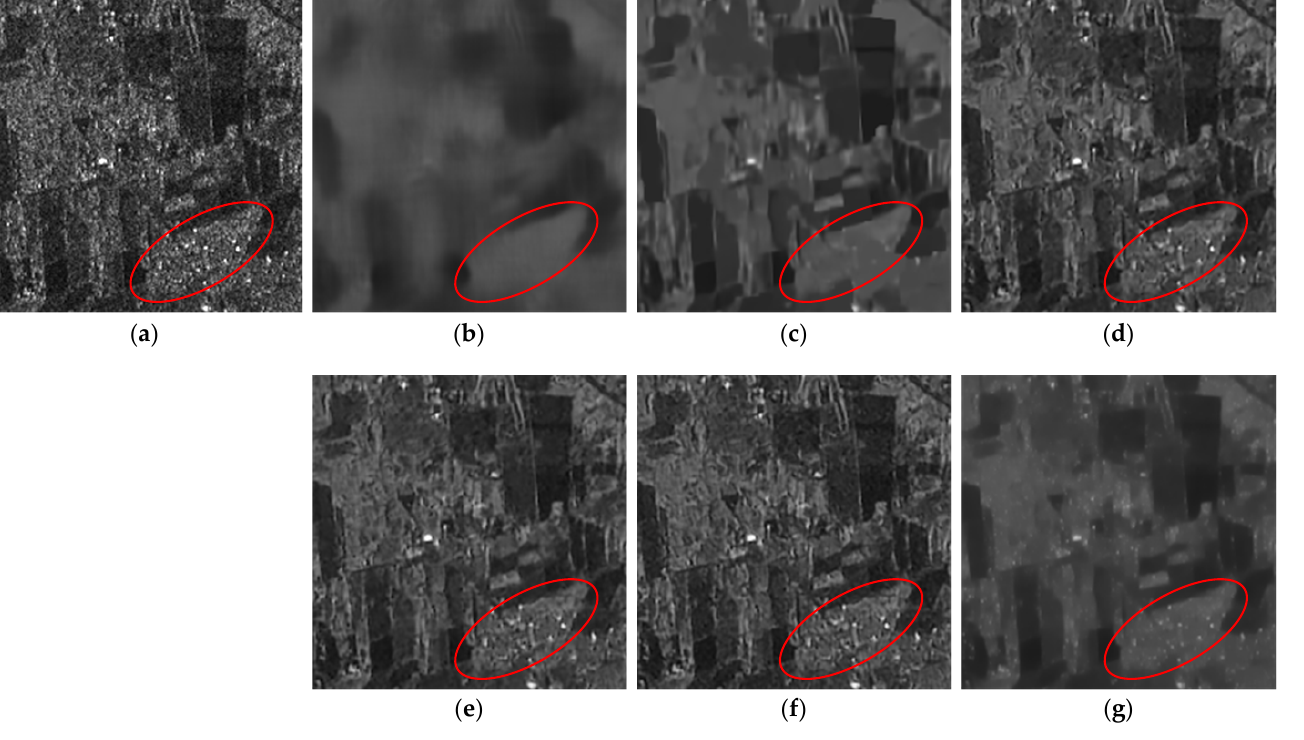
Figure 12. Magnified despeckling results for the Sentinel-1 #2 image. ( a ) Speckled. ( b ) PPB. ( c ) SAR-BM3D. ( d )